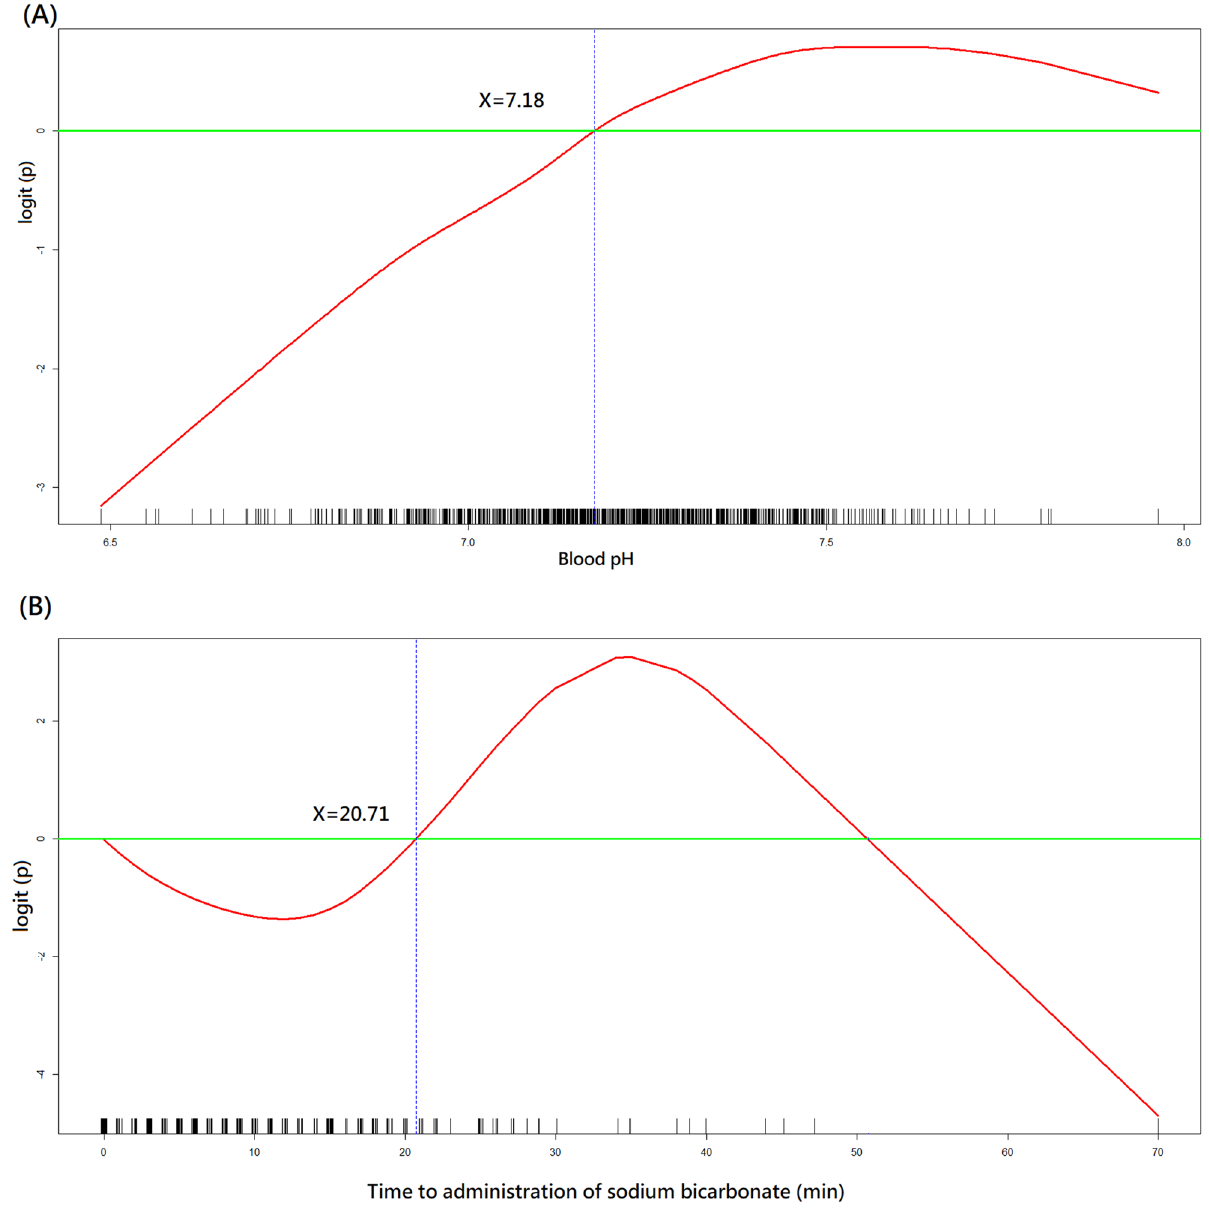
Figure 1. GAM plots. Nonparametric modelling of the effect of blood pH and time to administration of sodium bicarbonate on the logit of probability for favourable neurological outcome at hospital discharge. GAM, generalised additive